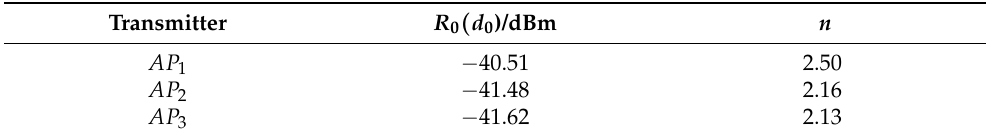
Table 3. Parameter estimation of Classic LDPLM.